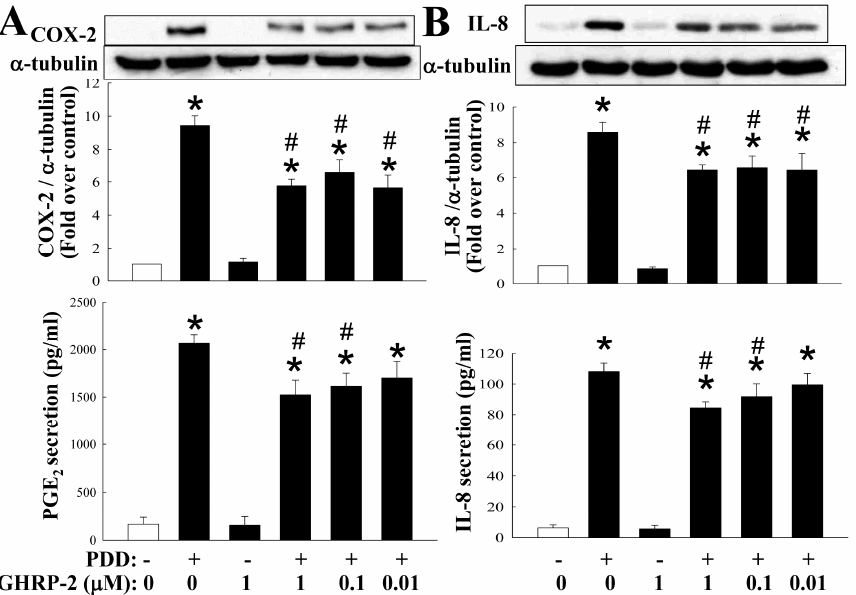
Figure 1. Growth hormone releasing peptide-2 (GHRP-2) inhibition of protein kinase C (PKC)-induced cyclooxygenase-2 (COX-2) and interleukin-8 (IL-8) expression and secretion of prostaglandin E2 (PGE 2 ) and IL-8 in KGN cells. Overnight plated KGN cells were pretreated with GHRP-2 (0.01, 0.1, and 1 µM) for 2 h, and then phorbol 12,13-didecanoate (PDD) (100 nM) was included for an additional 12 h. The intracellular COX-2 ( A ) and IL-8 ( B ) protein expression levels and the resulting PGE 2 ( A ) and IL-8 ( B ) protein concentrations in the cultured media were determined by Western blotting assay and ELISA, respectively. The results represent the means ± SEM (standard error of mean) ( n = 4). * p < 0.05 compared with the control; # p < 0.05 compared with the PDD treatment.